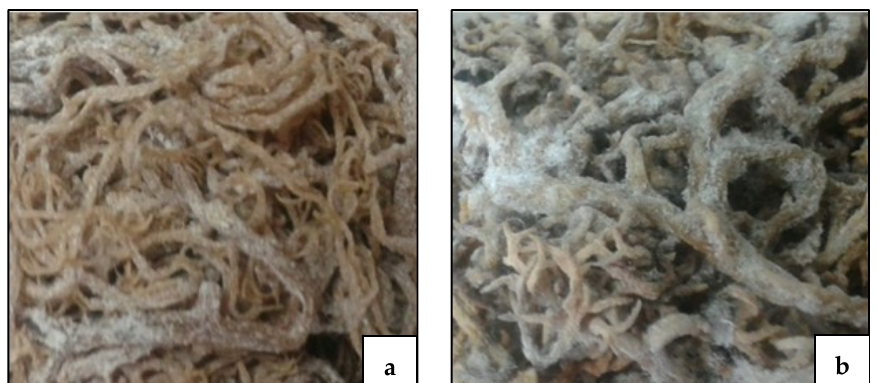
Figure 2. Dried samples of tropical eucheumatoids examined:( a ) Kappaphycus alvarezii ; ( b ) Kappaphycus striatus .